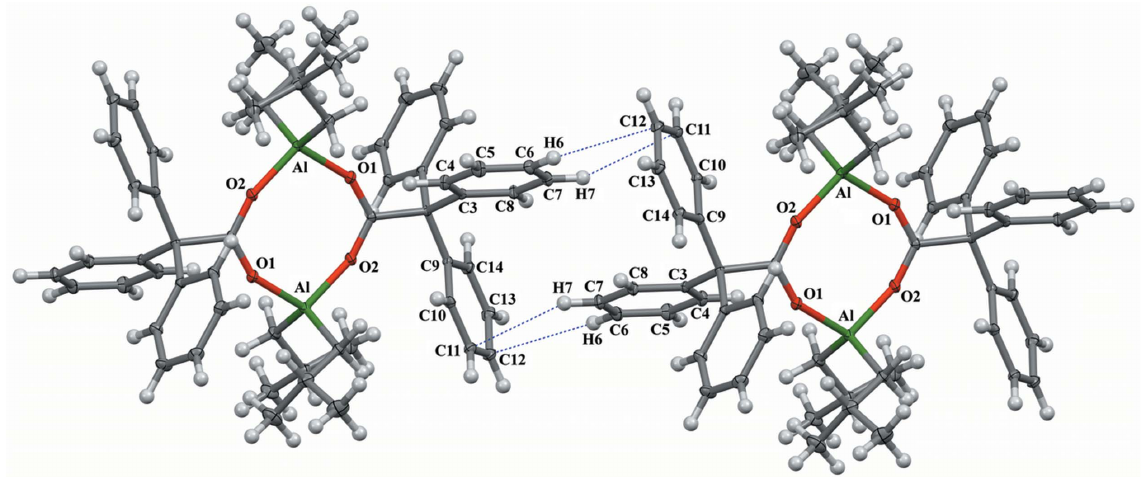
Figure 3 The intermolecular H Ph (cid:2)(cid:2)(cid:2) C Ph interactions between neighbouring molecules of [Al(iBu) 2 (O 2 CCPh 3 )] 2 . Displacement ellipsoids for non-H atoms are drawn at the 30% probability level.